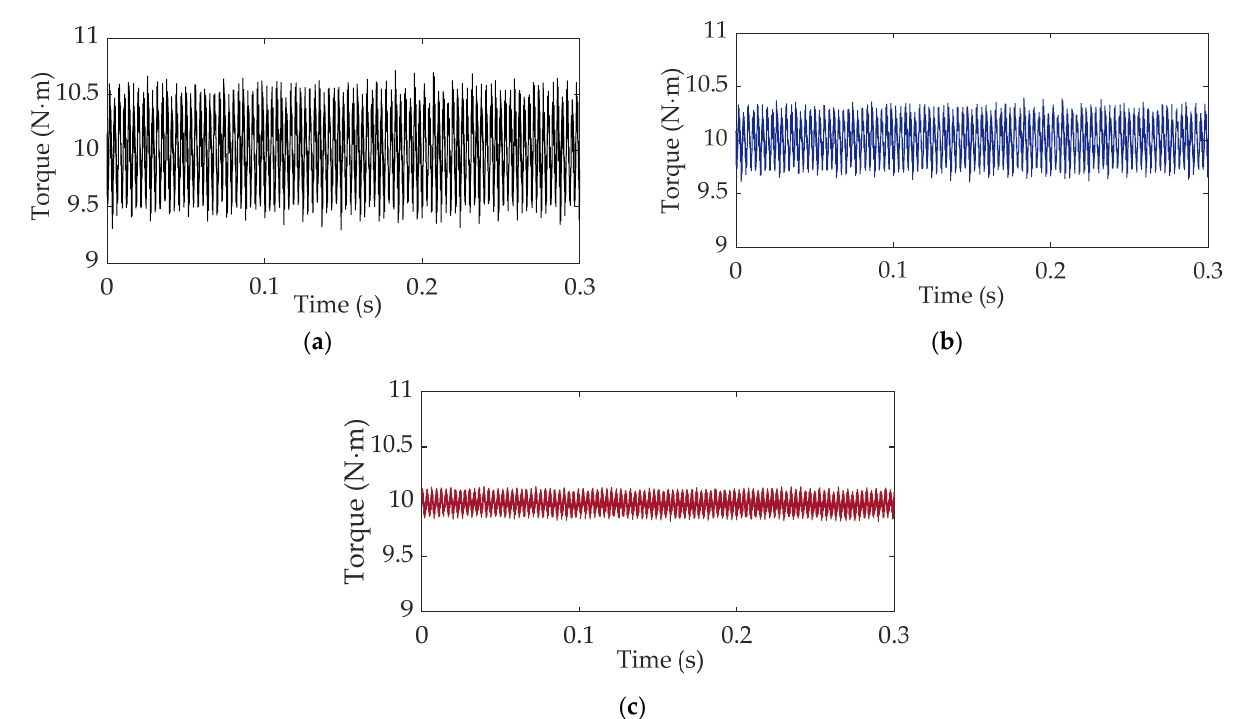
Figure 9. Torque at a steady-state speed of 1500r · min − 1 with a 10 N · m load for: ( a ) TDTC; ( b ) CMPTC; ( c ) proposed MPTC.